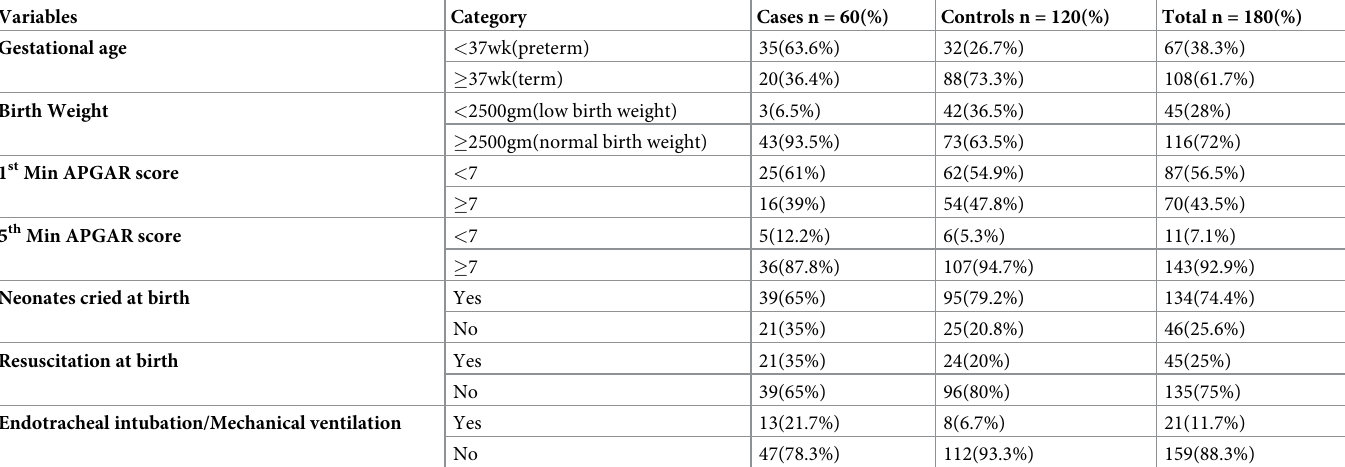
Table 3. Neonatal characteristics of the neonates admitted to NICU of Arbaminch general hospital, Gamo zone, Ethiopia.